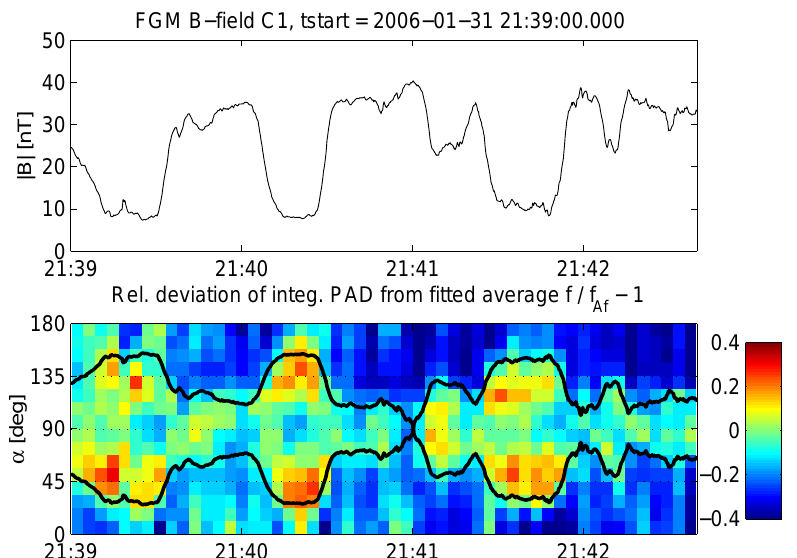
Fig. 5. Pitch angle distribution spectrogram integrated in energy for a second Cluster magnetosheath mirror mode event (31 January 2006). The panels correspond to panels (a) and (b) of Fig. 4.